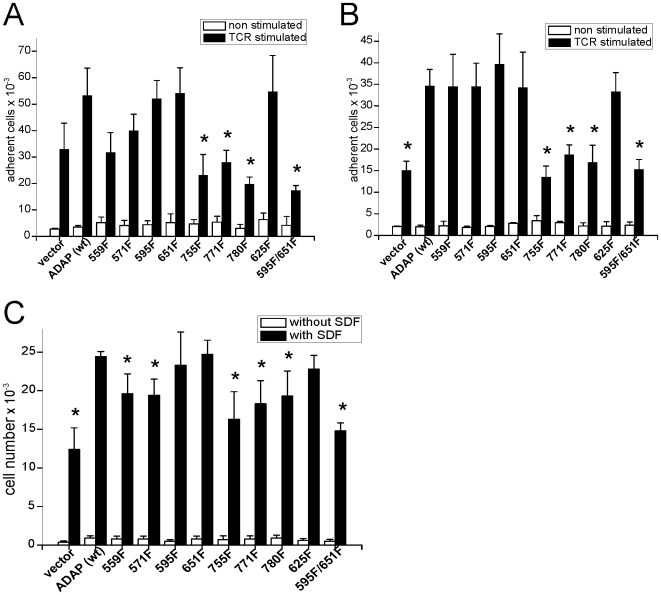
Cellular effects of tyrosine mutations.Mutations of ADAP tyrosines alter adhesion and migration of Jurkat T cells. A, B Adhesion assays of Jurkat cells on plates coated with fibronectin (A) or ICAM-1 (B) after overexpression of ADAP (wild type) or tyrosine to phenylalanine mutations at indicated positions. White bars: number of adhering cells without stimulation. Black bars: number of adhering cells after stimulation of cells with OKT3. C Migration of Jurkat cells through a transwell chamber in response to SDF-1. A-C: Average of absolute cell numbers from three experiments ± SD. “*” indicates significant deviation from stimulated ADAP (wild type) determined with Student's t-test.